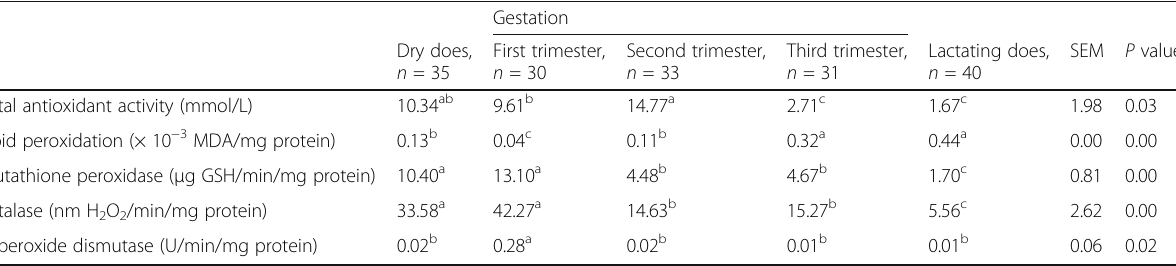
Table 2 Serum oxidative stress markers of WAD goats at different physiological stages